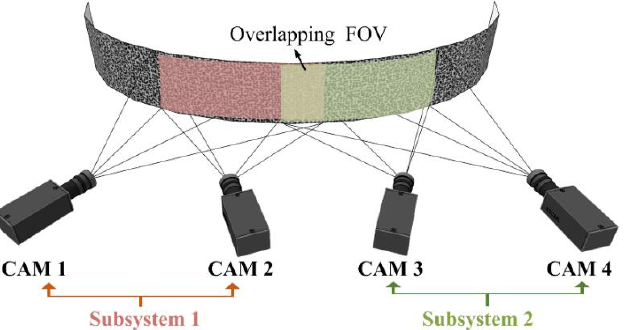
Figure 3. Schematic of a continuous-view MC-DIC system containing two stereo-DIC subsystems composed of four cameras: red shaded area and green shaded area denote the FOV of subsystem 1 and subsystem 2, respectively; yellow shaded area in middle is the overlapping FOV between subsystem 1 and 2.